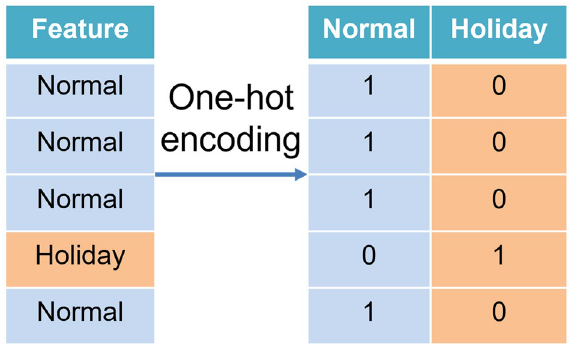
Figure 2. A sample one-hot encoding approach on the holiday